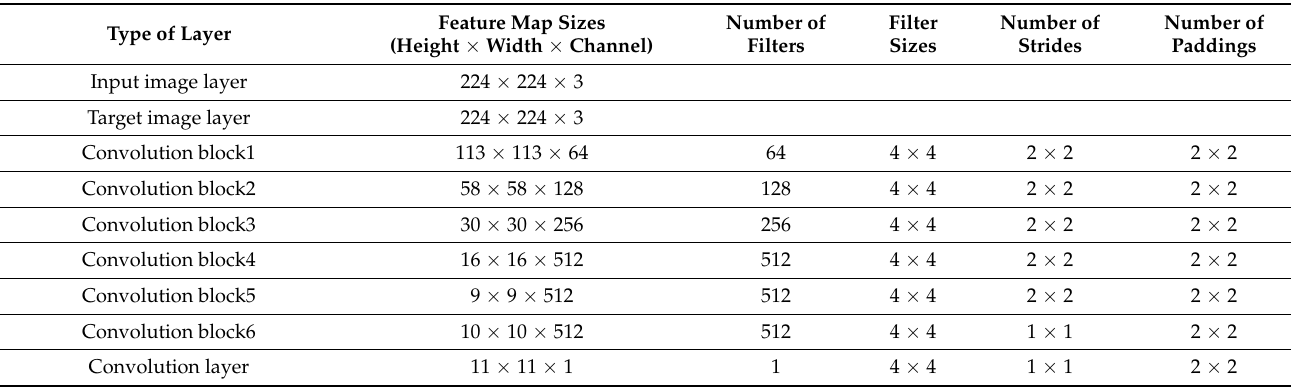
Table 3. Global discriminator of modified EnlightenGAN (convolution blocks through 1~6 include one convolutional layer and one Leaky ReLU layer).